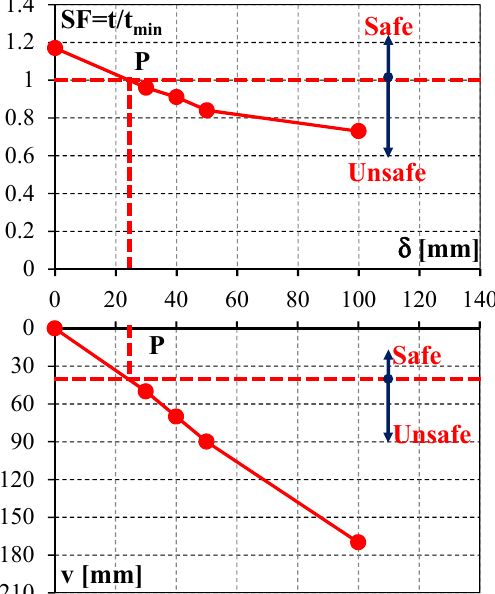
Figure 10. Plot of the geometrical safety factor SF ( top ) and of the geometrical vertical displacement v of the crown of the arch ( bottom ) versus the horizontal settlement δ imposed to the right constraint of the arch in the load test #2 for the arch in y-direction.